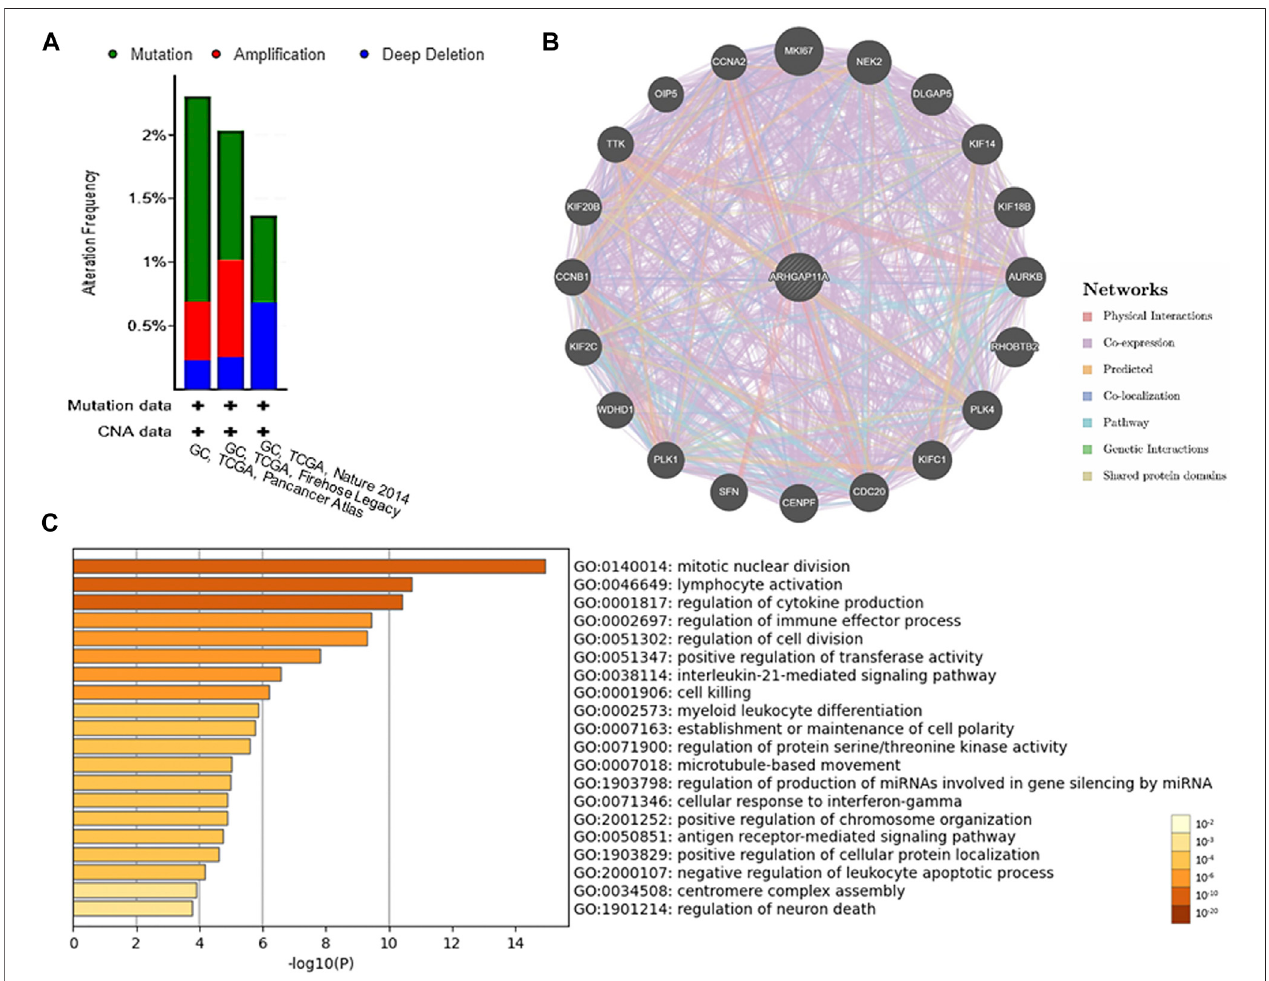
FIGURE 5 | Genetic alteration, PPI network and enrichment analyses of ARHGAP11A. (A) Genetic alteration of ARHGAP11A in gastric cancer. (B) PPI network of ARHGAP11A in GeneMANIA. (C) A heat map of GO function and KEGG pathway analysis of ARHGAP11A and its interacting proteins.